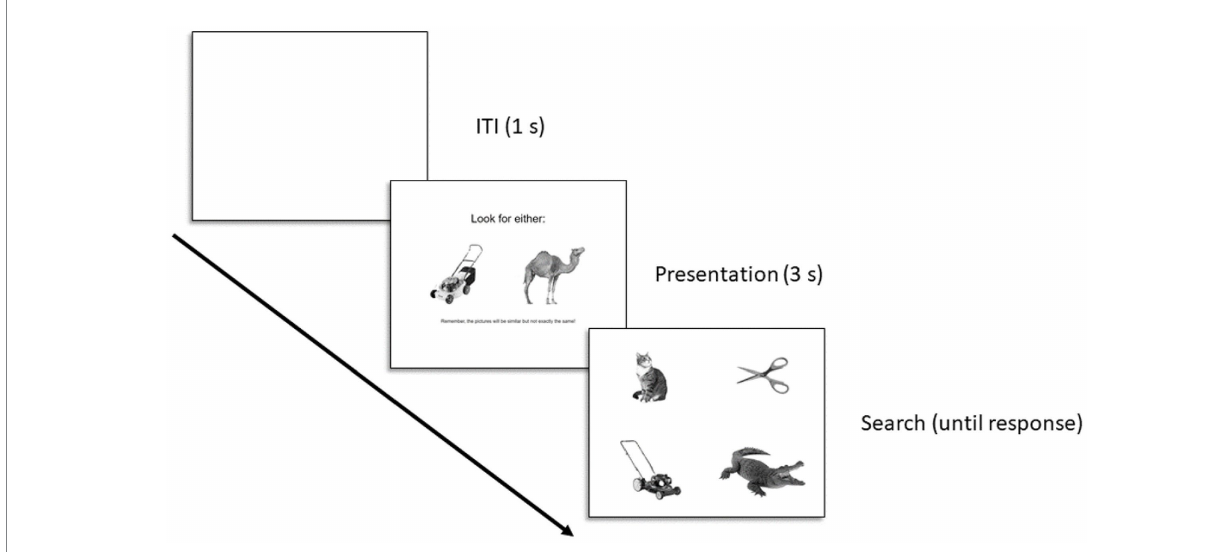
FIGURE 1 Trial structure for Experiment 1. The text below the images on the presentation display read: “Remember, the pictures will be similar but not exactly the same!”.